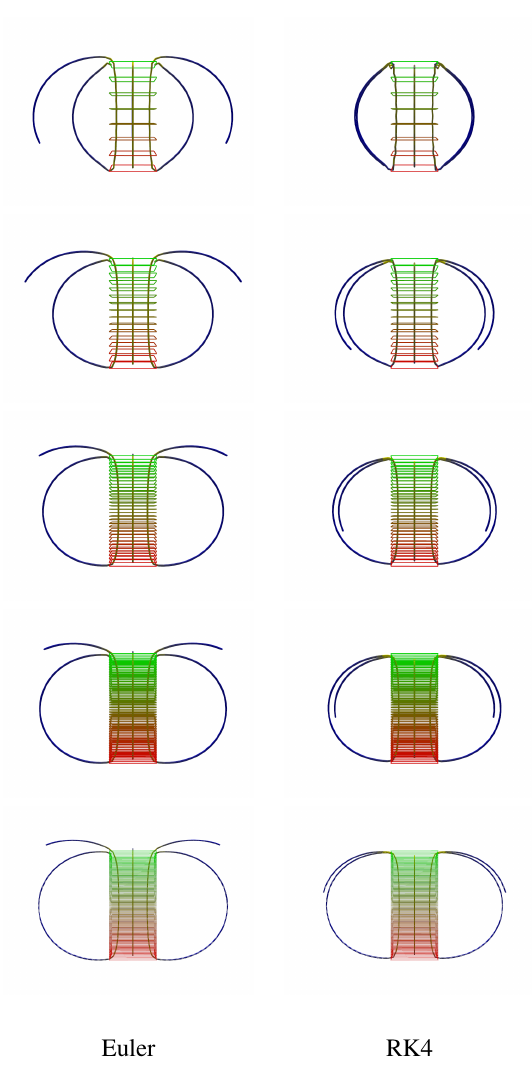
Comparison of Euler and Runge-Kutta integration methods. The magnets are created of 8, 16, 32, 64 and 128 wire-circuits (f.t.t.b.), to show the different calculation